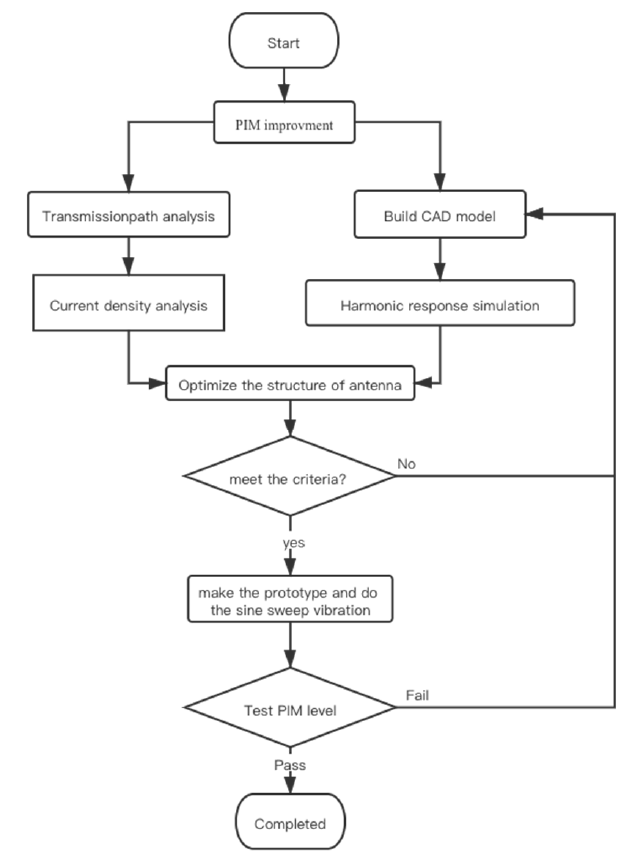
Figure 6. The new workflow of PIM improvement.